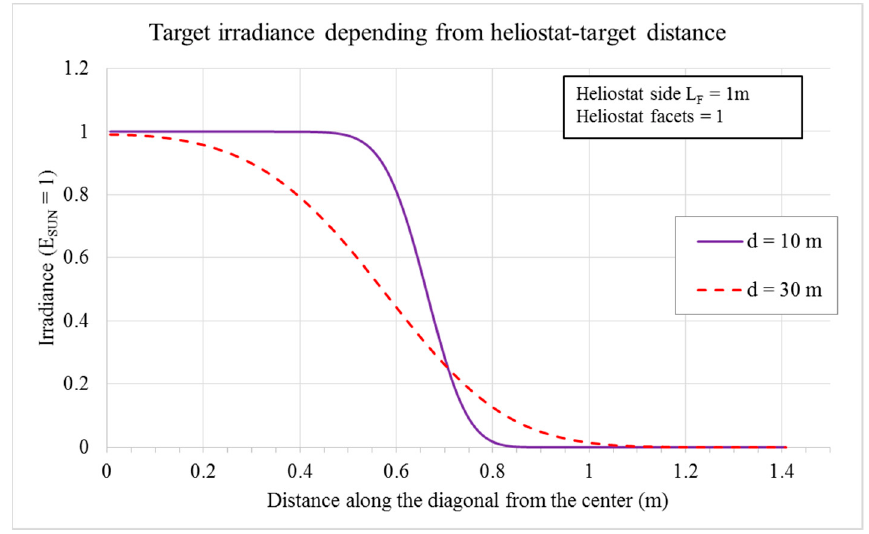
Figure 16. Comparison between simulated irradiance profiles at two distances from the target.